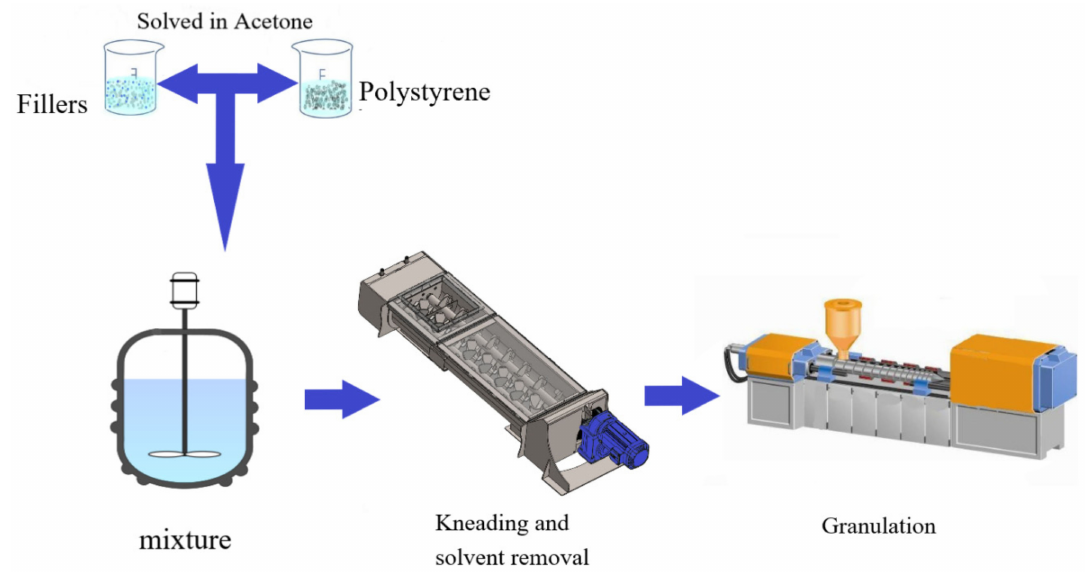
Figure 1. Schematic of preparation